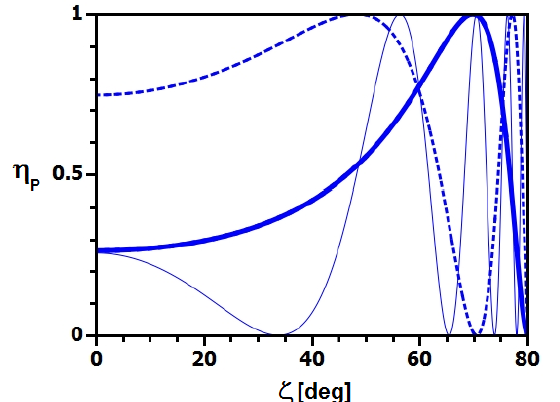
Figure 13. Pendell¨osung oscillations: η versus ζ calculated for the grating parameter sets P Λ = 0 . 5 µ m, d = 100 µ m, b ∆ ρ = 2 . 7 µ m − 2 (thick solid line) and Λ = 1 µ m, d 0 c b ∆ ρ = 5 . 8 µ m − 2 (dashed line) at λ = 4 nm. For the second parameter set, the oscillation is c also shown for λ = 10 nm (thin solid